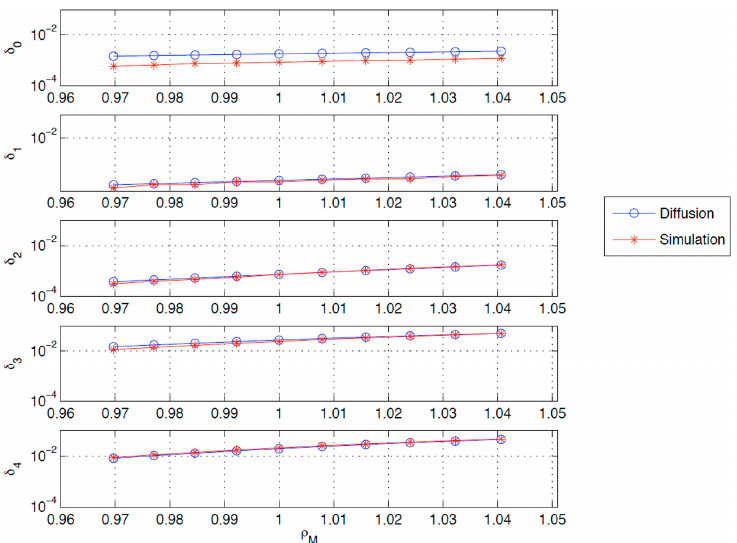
Figure 9. Probabilities of overflow versus normalized system loads. X is truncated exponential with a maximum size four times the mean, K 0 = 10, K 1 = 20, K 3 = 30, K 3 = 40, K 4 = 50.